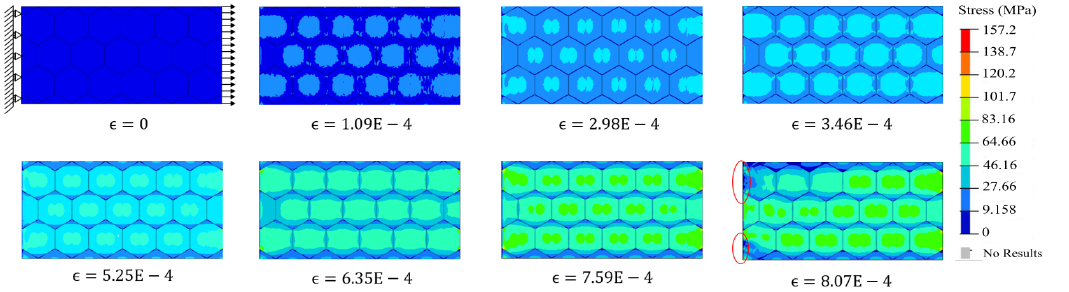
Figure 5. Evolution of maximum principal stress with longitudinal strain increment. The failure is observed when local maximum principal stress reaches to 160 MPa at the fixed end of the composite as encircled in red. The contours are shown for E o = 3.78 GPa and 5% organic matrix by